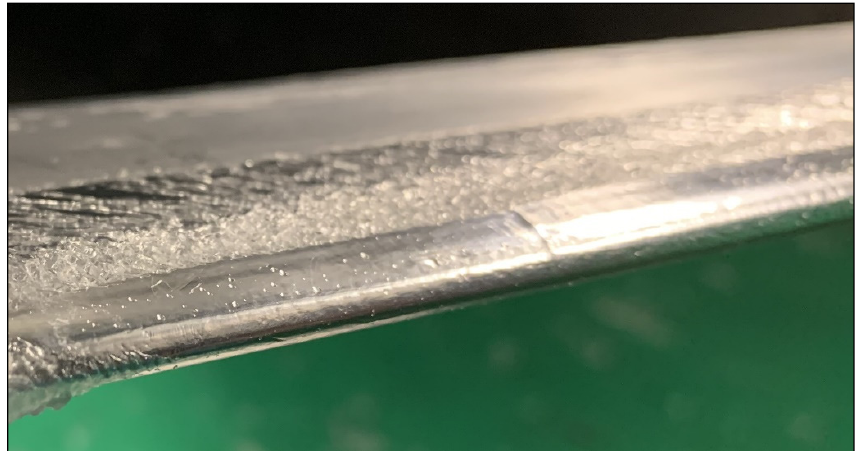
Figure 5. A Photo of the Result of Anti-Icing Tests When the Ice Began to Accrete on the Previously Ice-Free Leading Edge Due to Gradual Reduction in Power Applied to the Activated Heaters; Ice Is Additionally Seen behind the Leading Edge and on the Blade Tip.